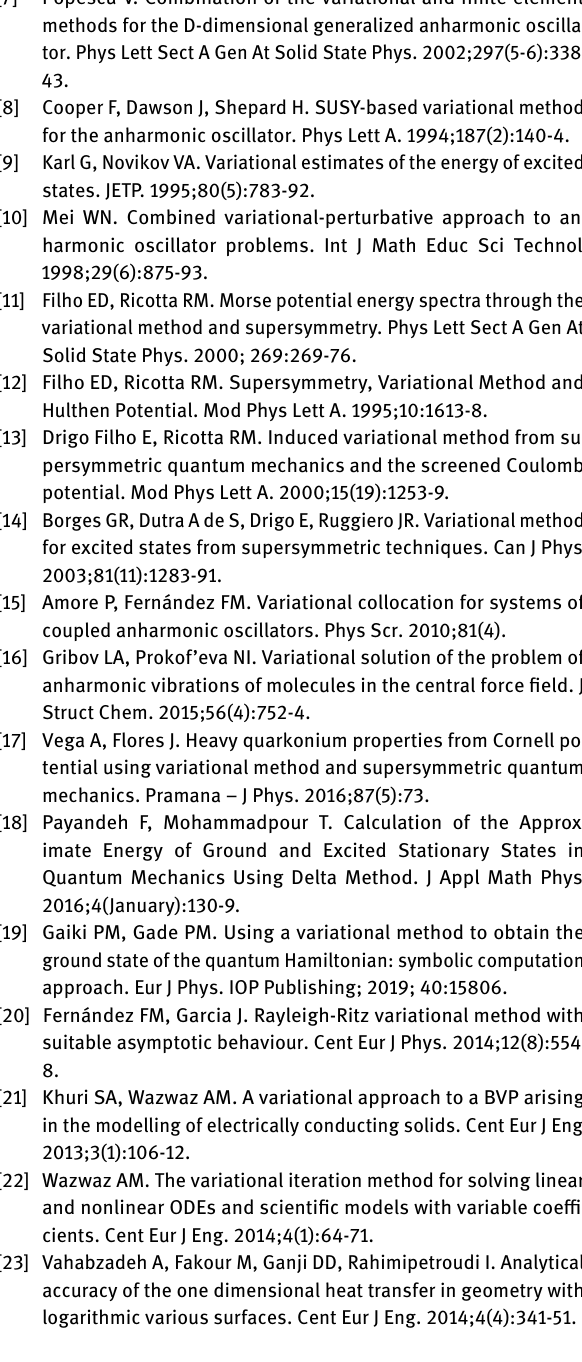
state energy: E vm = 0.905322 and E nm = 0.905322.